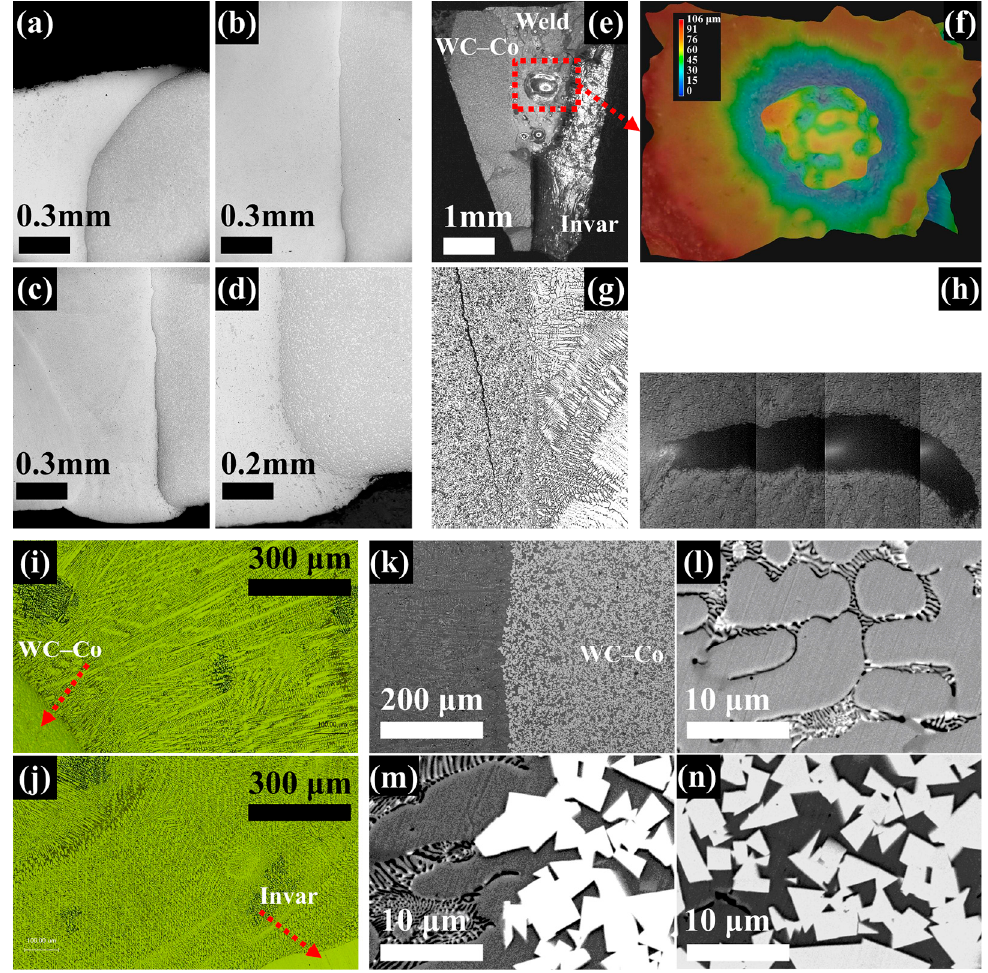
Figure 8. Laser–TIG hybrid welding of cemented carbide and steel without filler metals. As-welded microstructures (cross-sectional view) of the ( a ) top side, ( b ) middle, and ( c ) bottom. ( d ) Higher-magnification image showing the WC dissolution. ( e , f ) Porosities. ( g , h ) Cracks. ( i , j ) Optical micrographs of the fusion boundary on the WC–Co side and steel side. ( k ) SEM images of the fusion boundary on the WC–Co side and magnified images of the microstructure ( l ) in the fusion zone, ( m ) on the fusion boundary on the WC–Co side, and ( n ) of the cemented carbide. Adapted from [75], with permission from Elsevier, 2011.